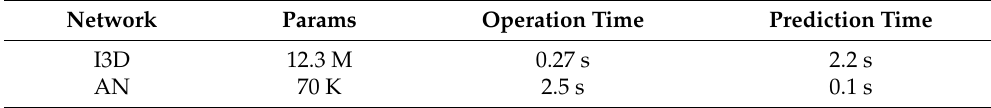
Table 3. Resources and time consumed by the